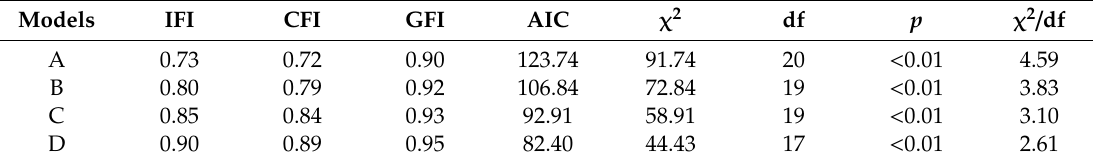
Table 5. Fit statistics of the Athens Insomnia Scale (AIS) scores in Indian computer professionals.